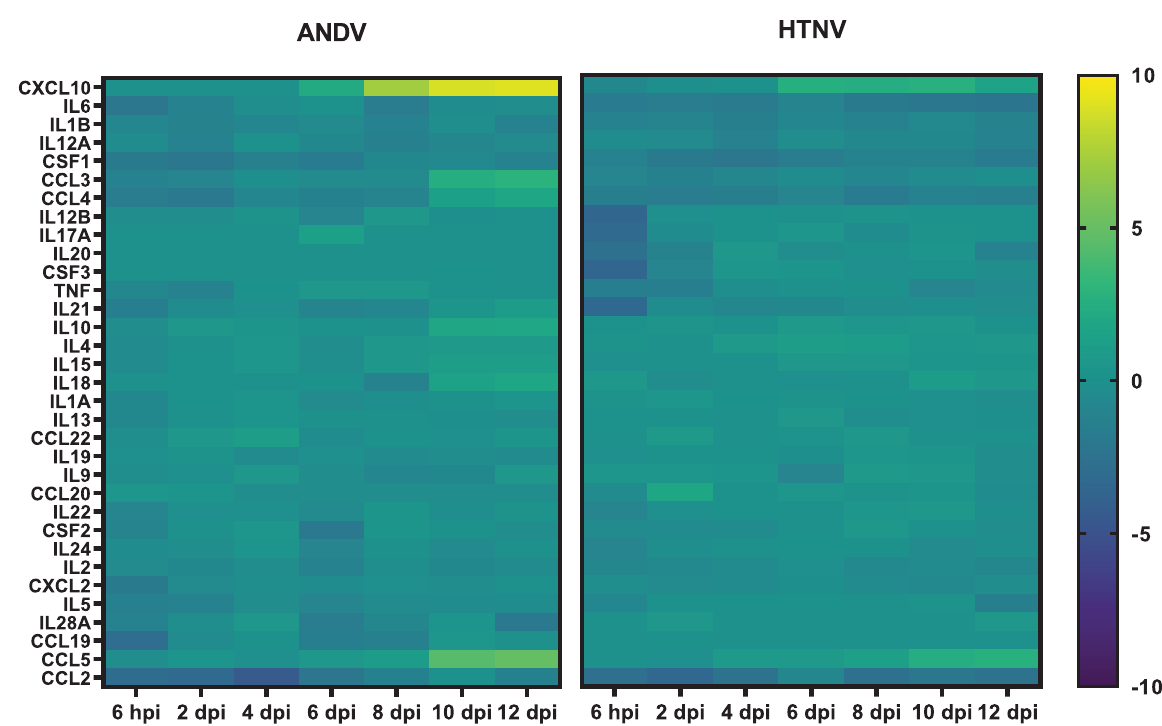
Fig 6. Cytokine/Chemokine Expression in Hantavirus Infected Hamsters. Genes associated with cytokine and chemokine expression are displayed as a heat map with hierarchical clustering and intensity of the colors corresponding to the magnitude of fold change over the baseline.